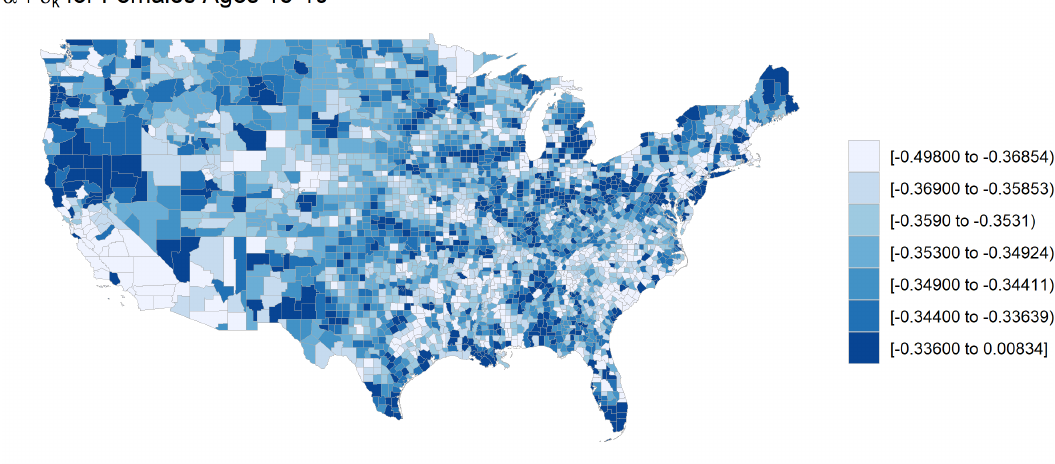
Figure 11. County-level time trends ( α + δ k ) for females ages